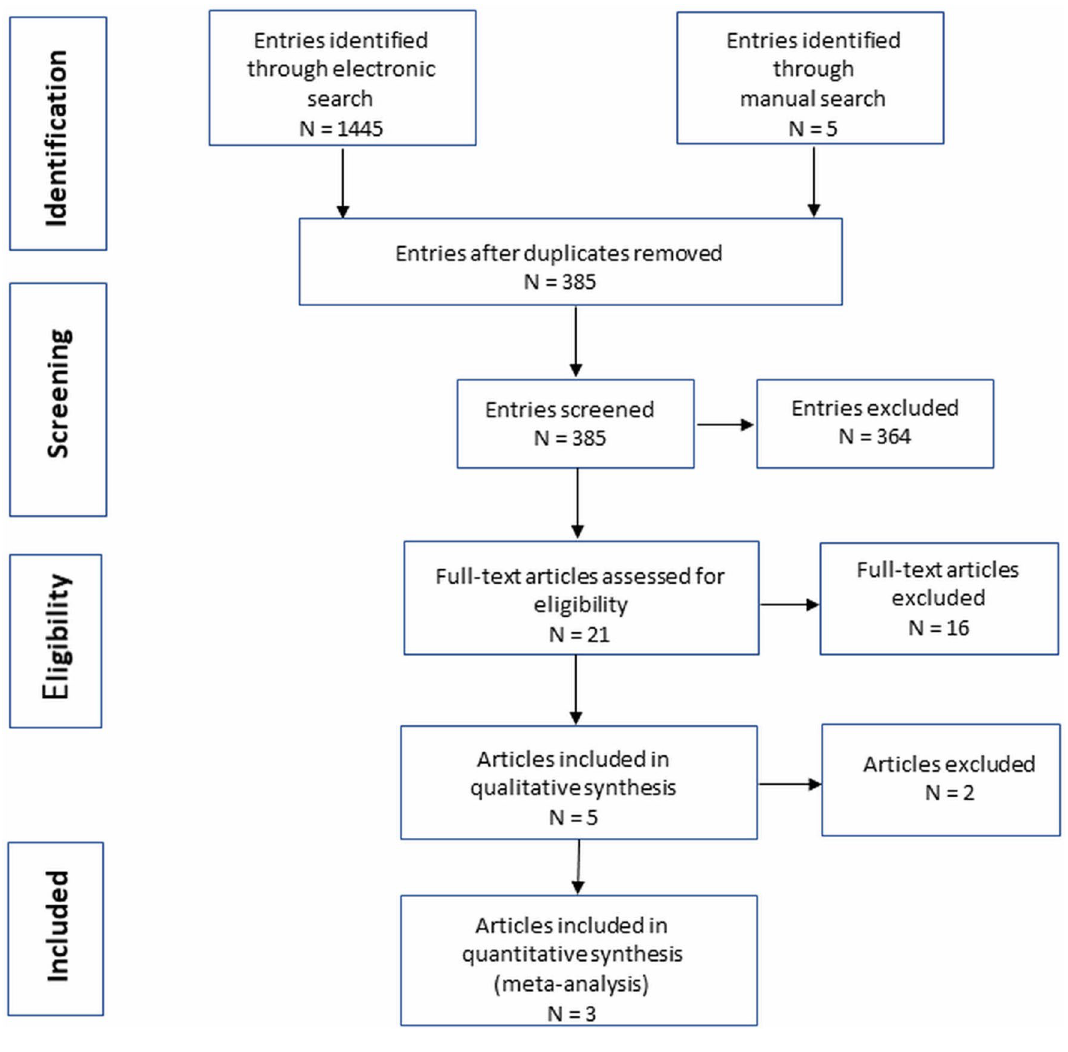
Figure 6. Flowchart of literature search.